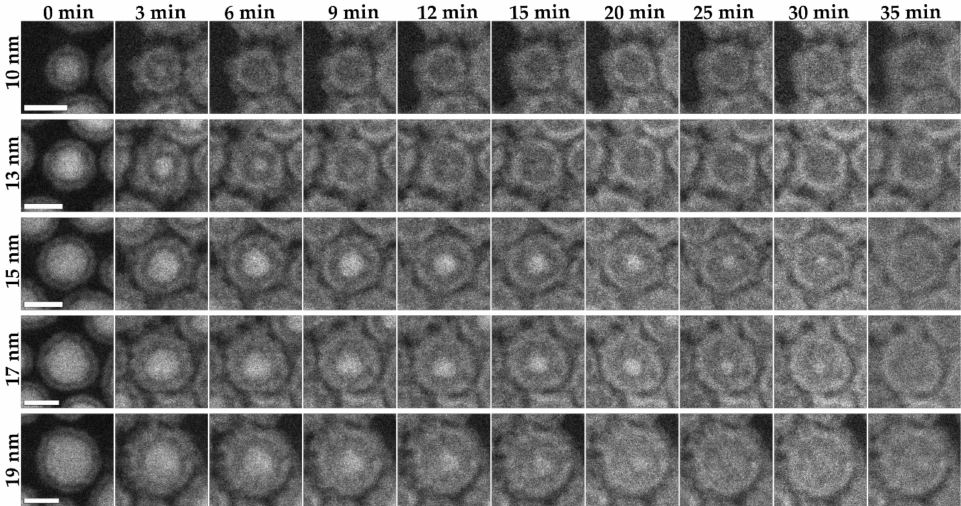
Figure 4. In situ visualization and analysis of dynamic oxidation of Fe 2 C nanoparticles in HAADF- ESTEM at 200 ◦ C with 2 Pa oxygen. The figure shows nanoparticles with increasing particle sizes (10–19 nm) over a period of 35 min. The images have a 10 nm scale bar.